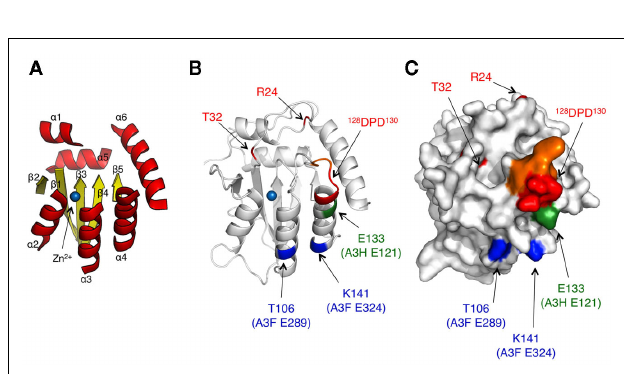
FIGURE 2 | Model structure ofA3G NTD and location of responsible residues forVif interaction. (A) Ribbon diagram of the A3 core structure for the model is depicted based on the crystal structure of the A3G CTD (PDB ID# 3IR2).The loop regions are removed.The α helices ( α 1–6) and β sheets ( β 1–5) are shown in red and yellow, respectively. (B,C) In the structure model, the amino acid determinants,T32, R24, and 128 DPD 130 , for A3G are colored in red.The analogous residuesT106 and K141 in A3F E289 and E324 (blue), and E133, corresponding to A3H E121 (green) are also shown.The critical residues, 125 YFW 127 , for nucleic acid binding are colored in orange. (C) Predicted surface of the A3G NTD model is shown. All the critical residues are predicted to be surface